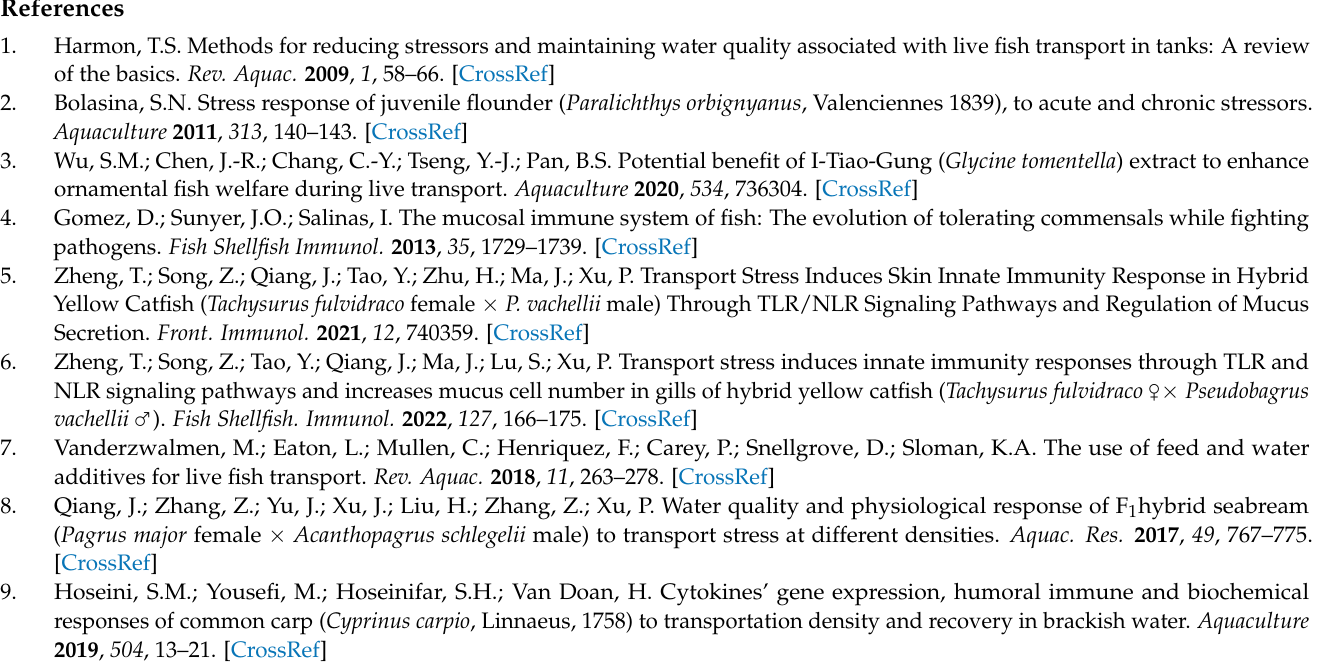
Figure S2: Linear discriminant analysis effect size (LEfSe) analysis comparing abundance of all detected bacterial taxa among yellow catfish in control group, transport group and recover group. Table S1: Overview of reads for mRNA-seq and quality filtering; Table S2: Differentially expressed mRNA verified by mRNA-Seq; Table S3: The specific primer sequences for qPCR in this